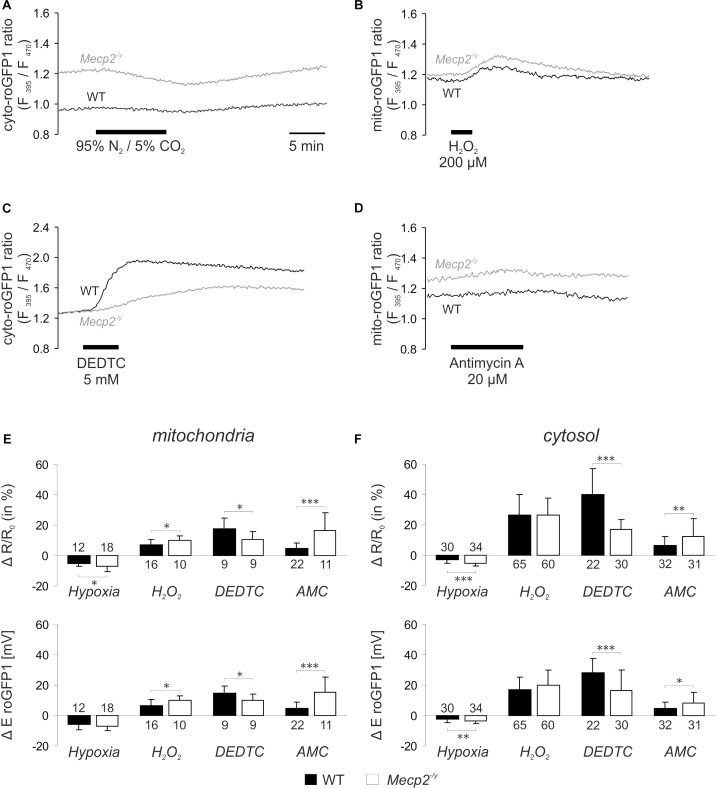
Acute redox challenge uncovers a more fragile redox homeostasis in mitochondrial matrix and cytosol of Mecp2-/y hippocampal neurons. (A) As revealed by the imaging of subcellular redox dynamics, O2 withdrawal evoked a reducing shift in the cytosolic roGFP1 fluorescence ratio, which was more intense in Mecp2-/y neurons. Time scaling also applies to the following traces. (B) Low-dose H2O2 induced a more pronounced oxidation in Mecp2-/y mitochondria. (C) The cytosol of Mecp2-/y neurons responded less intensely to DEDTC, a blocker of SOD1. (D) Block of CIII by AMC elicited a more pronounced oxidation in Mecp2-/y mitochondria. (E) Summary of the redox alterations in mitochondrial matrix. Plotted are changes in mito-roGFP1 ratio and in the mito-roGFP1 reduction potential. Asterisks indicate statistically significant differences as compared to WT in unpaired two-tailed t-tests (∗∗∗p < 0.001, ∗∗p < 0.01, ∗p < 0.05). The number of cells studied is reported for each bar. (F) Summarized redox responses of the cytosolic compartment (cyto-roGFP1).